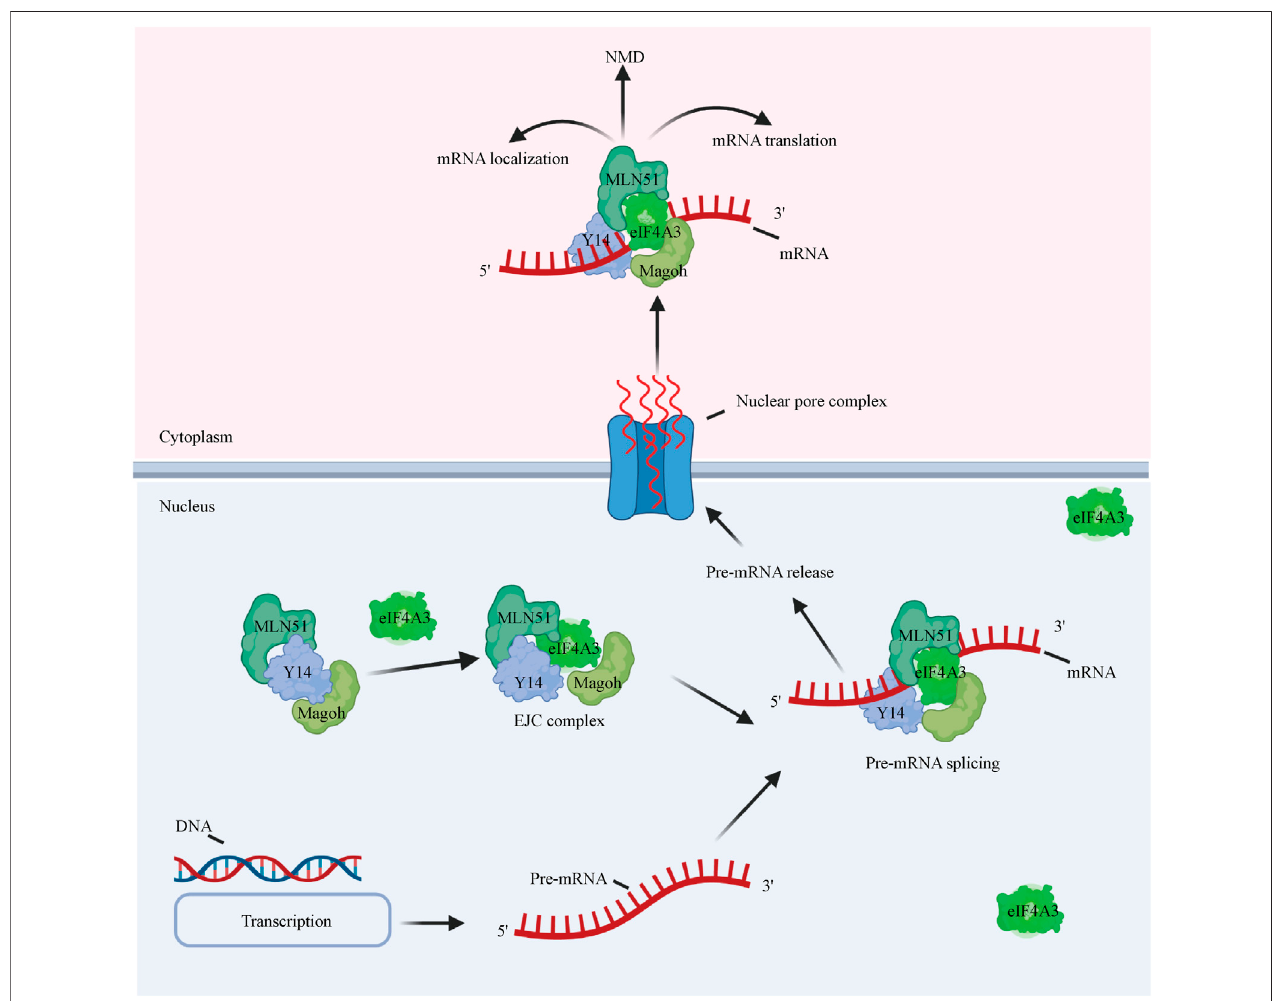
FIGURE 3 | eIF4A3 affects premRNA splicing and mRNA metabolism. eIF4A3 is an essential component of the EJC and serves as a nucleation center to recruit other EJC components (i.e., the Y14/Magoh heterodimer and MLN51). The complex binds the mRNA to facilitate its translocation to the cytoplasm from the nucleus to facilitate downstream processes, such as the NMD pathway, mRNA localization, and translation.